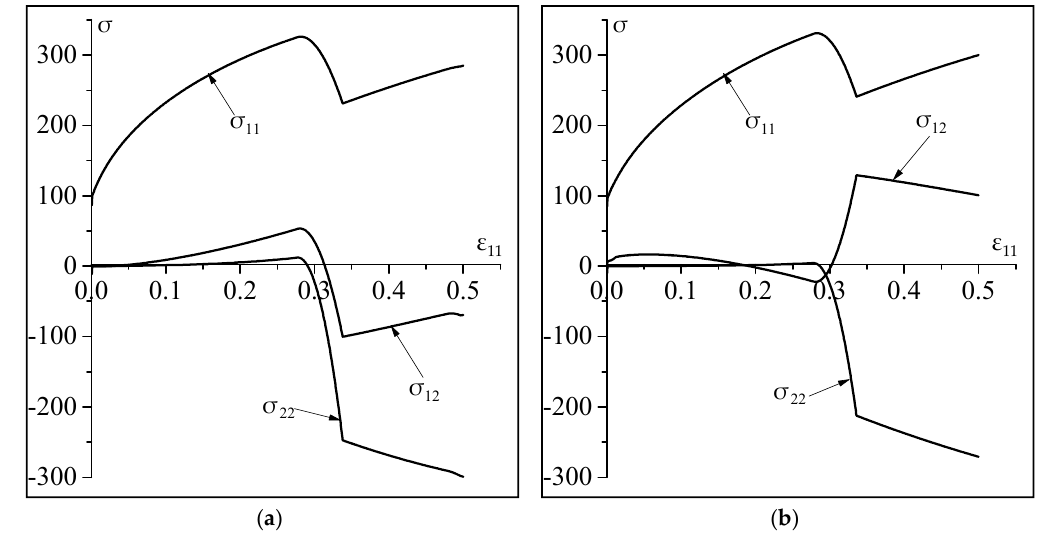
Figure 3. Impact of the non-Schmid effects on the evolution of the in-plane components of the Cauchy stress tensor: ( a ) Results without non-Schmid effects (a 1 = a 2 = a 3 = 0); ( b ) Results with non-Schmid effects (a 1 = 0.2;a 2 = a 3 =